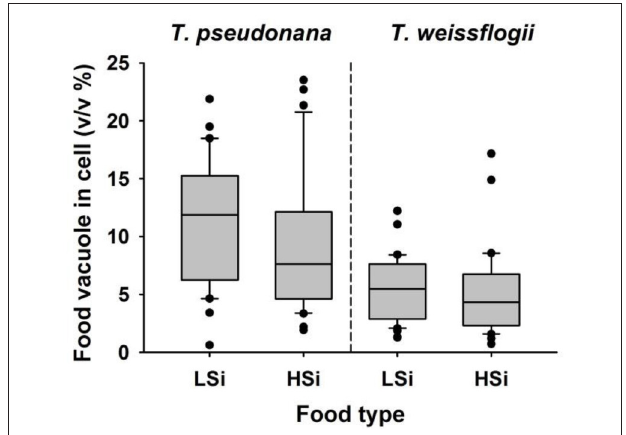
FIGURE 5 | Change in percentage of food vacuoles over time in Noctiluca scintillans cells that have ingested T. weissflogii (A) or T. pseudonana (B) with different silica contents. LSi and HSi are low and high silica diatom prey, respectively. Error bars indicate 1 SD ( n = 4–6).